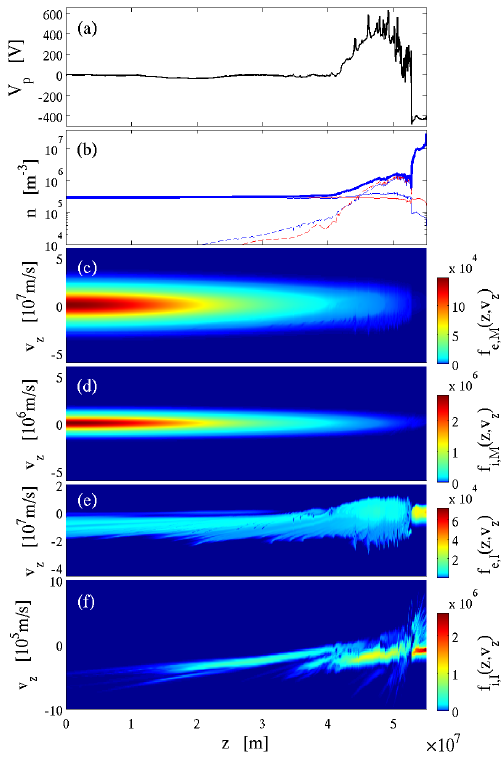
Figure 1. Simulation state at t = 130s in the run with V p , I = − 400V and 4 × 10 7 m − 3 . (a) Plasma potential as a function of z . (b) Densities as functions of z . The thick blue curve shows the plasma density. The thin solid curves show protons (red) and elec- trons (blue) from the magnetospheric end of the system. The dashed curves show protons (red) and electrons (blue) originating from the ionosphere. (c) – (f) Phase space densities for (c) magnetospheric electrons; (d) magnetospheric protons; (e) ionospheric electrons; and (f) ionospheric protons. The colour scales have been normalised so that integrals over all v z yield n s /B . The unit for f (z,v z ) is m − 4 T − 1